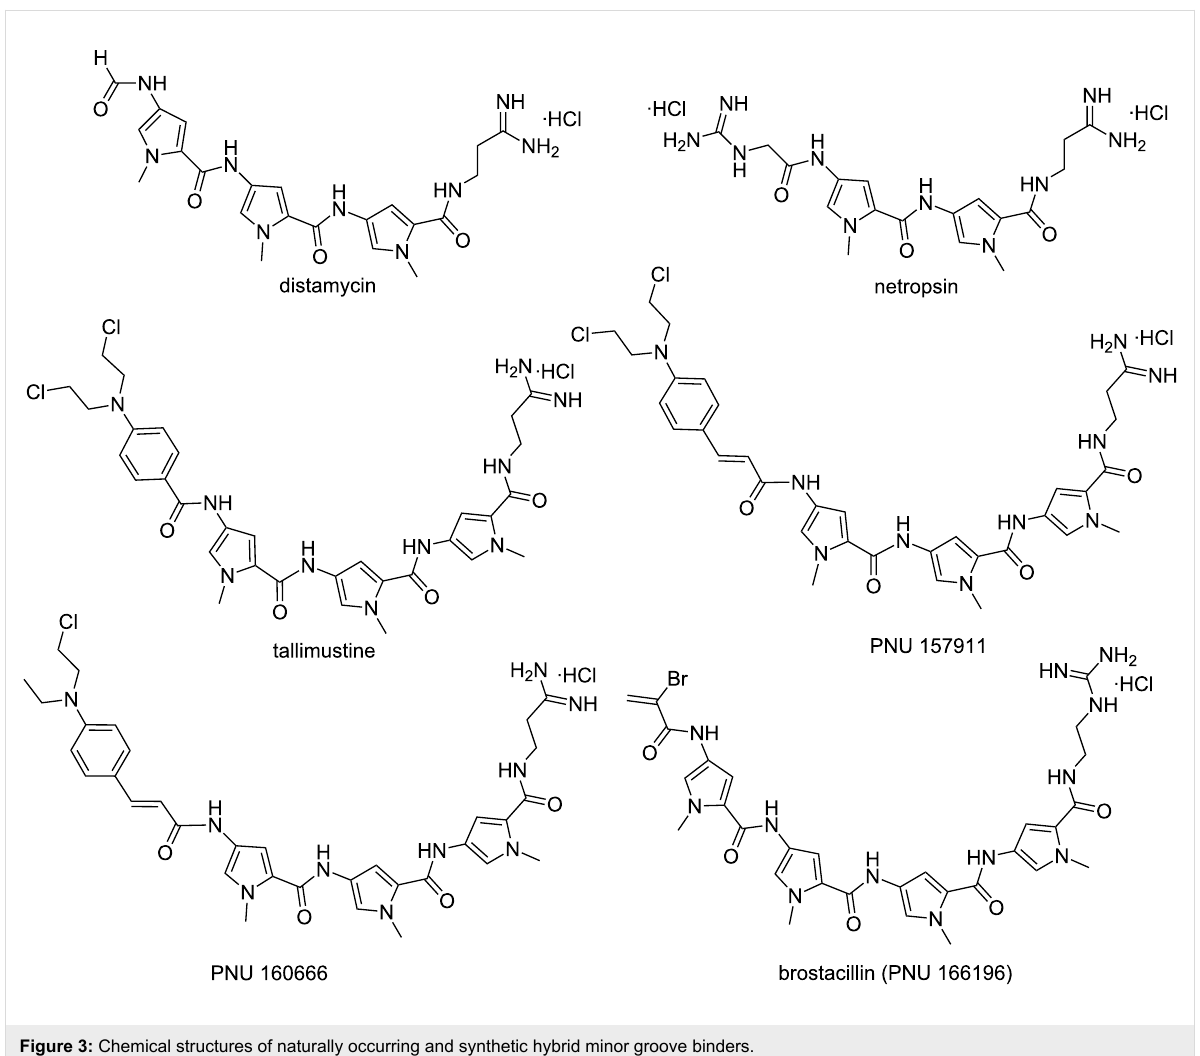
Figure 3: Chemical structures of naturally occurring and synthetic hybrid minor groove